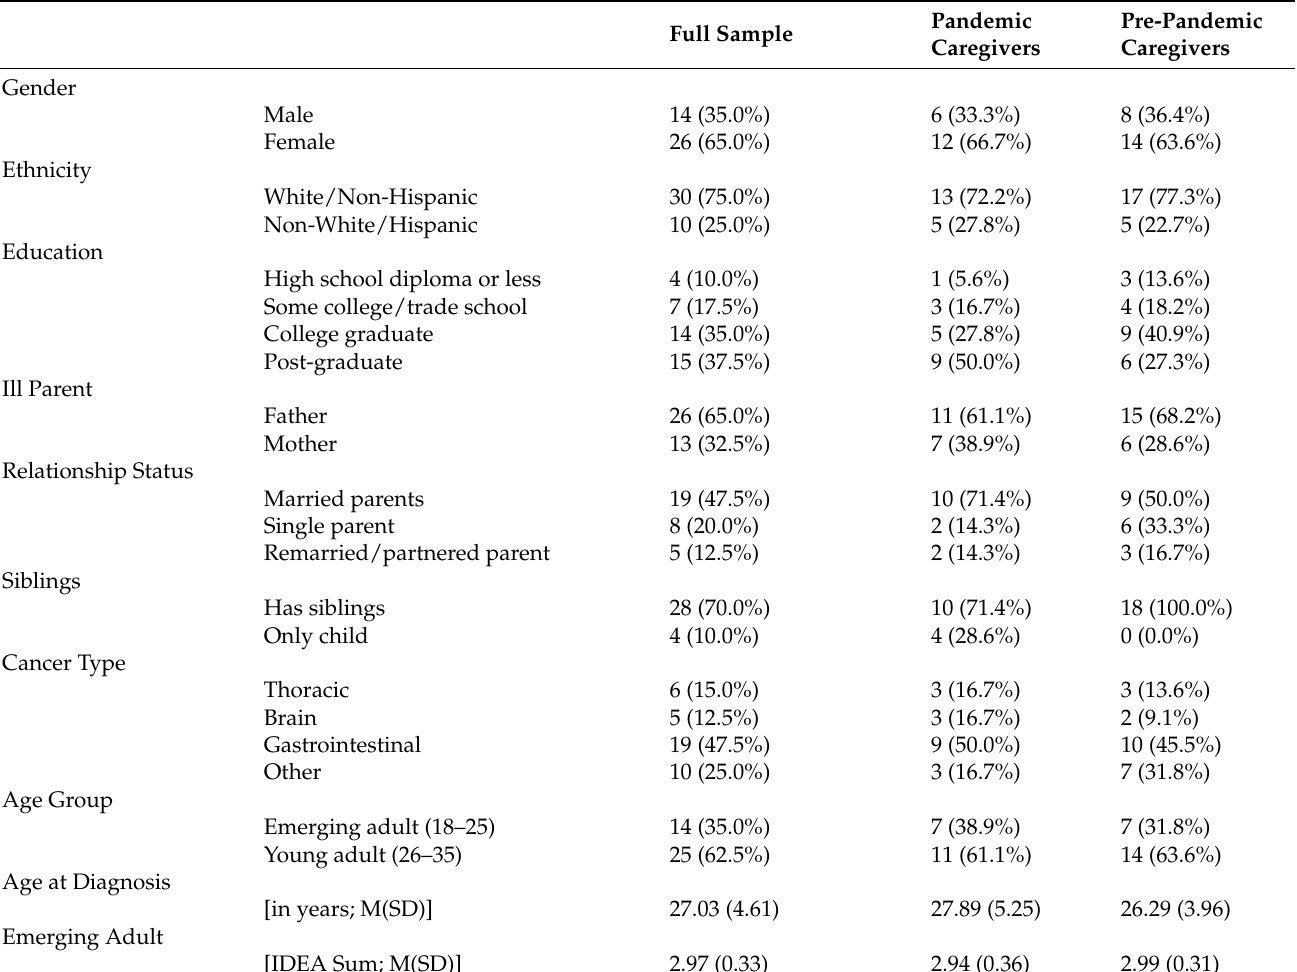
Table 1. Sample Demographics, n